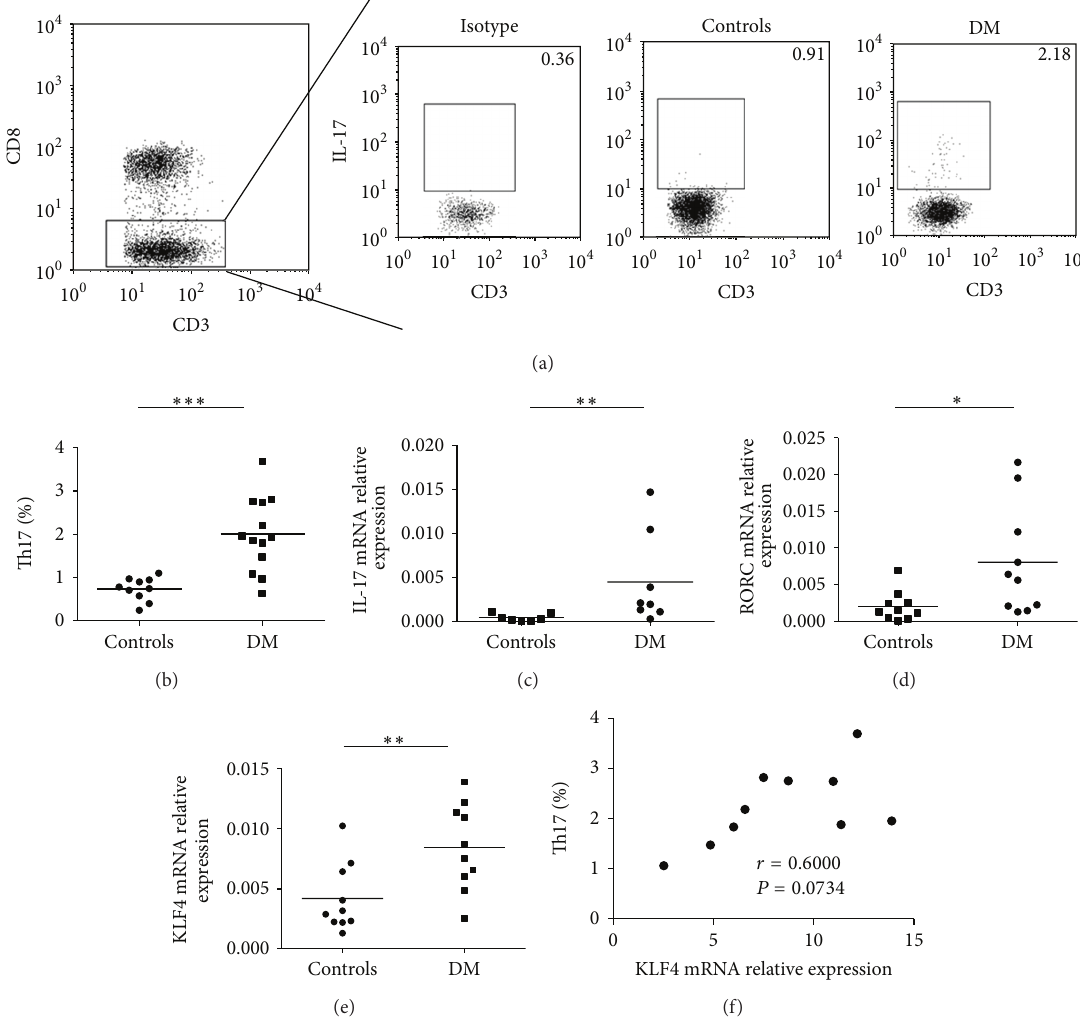
Figure 1: Th17 cells in the peripheral blood from DM patients. PBMCs from DM patients and healthy controls were incubated with PMA/ionomycin, stained for cell surface molecules CD3 and CD8 as well as intracellular IL-17, and analyzed by flow cytometry. (a) Representative dot plots from DM patient and a control subject are shown. Values correspond to the percentage of Th17 lymphocytes. We used isotype controls to determine the positive cells, and all the values are gated on the CD3+CD8 − cells. (b) Percentages of Th17 lymphocytes were compared between DM patients and control subjects. (c) Levels of IL-17 mRNA in PBMCs pretreated with PMA/ionomycin from DM patients and controls. (d) The levels of RORC mRNA in PBMCs were detected by real-time PCR from DM patients and healthy controls. (e) The levels of KLF4 mRNA in PBMCs were detected by real-time PCR from DM patients and healthy controls. (f) The correlation between the percentages of Th17 lymphocytes and the expression of KLF4 mRNA in PBMCs from DM patients. Each data point represents an individual subject; horizontal lines show the mean. ∗ 𝑃 < 0.05 ; ∗∗ 𝑃 < 0.01 ; ∗∗∗ 𝑃 < 0.001